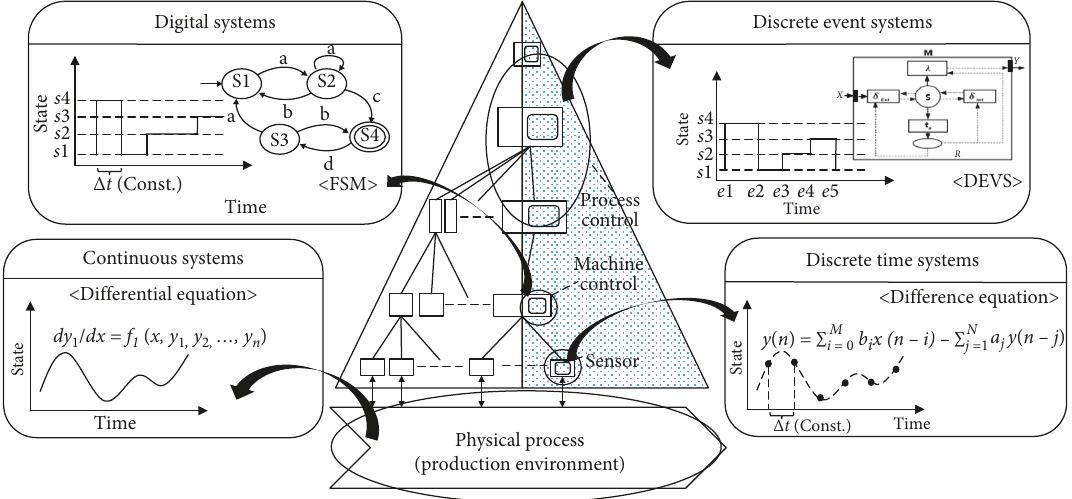
Figure 3: Dynamical models in cyber-physical production